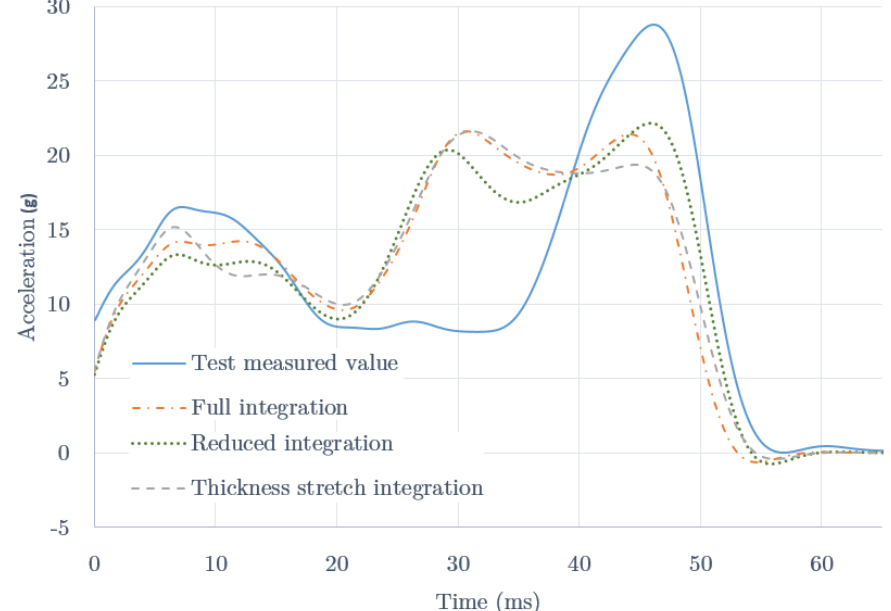
Figure 6. Acceleration (g) as function of the time (ms) during the crushing test. The initial time is provided by the impact switch. The data corresponds to the test measured values (solid line) and the three different formulations analyzed in our study for the integration of the mesh elements of the impact attenuator: reduced integration (dotted line), full integration (dash-dotted line) and thickness-stretch integration (dashed